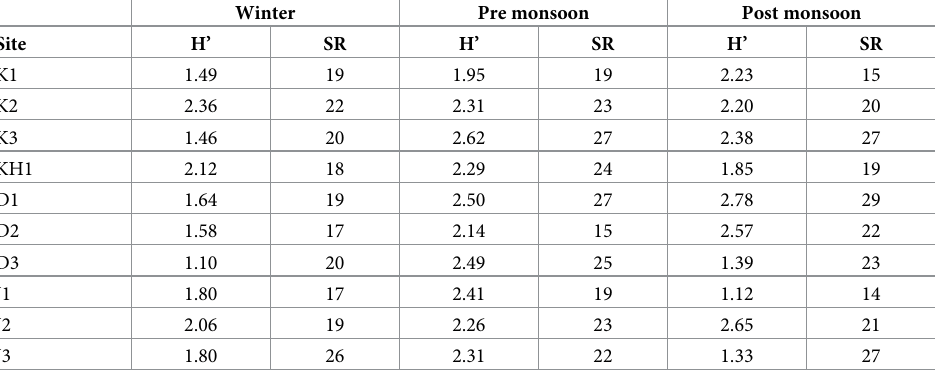
Table 5. Details of diversity (H’) and richness (SR) for sampling locations during seasonal sampling periods in West Bengal. Winter Pre monsoon